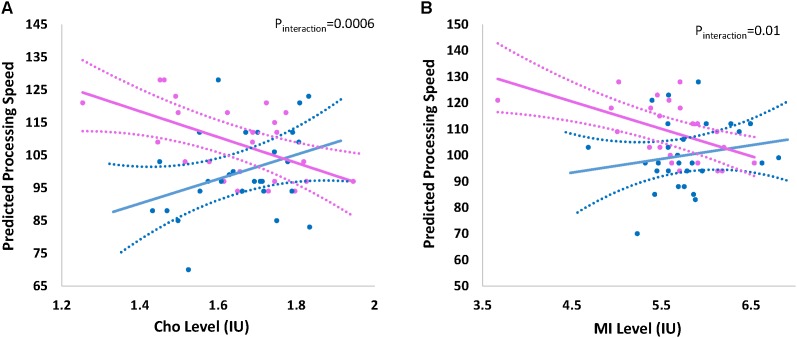
Effect of (A) choline and (B) myo-inositol on processing speed by sex. Graph represents the effect of (A) choline (Cho) and (B) myo-inositol (mI) on the predicted processing speed of participants by child’s sex Sex-stratified regression models are adjusted for age at visit/testing. Blue and pink indicates the effect for males and females, respectively. Dashed lines represent 95% confidence intervals. Actual individual level data are overlaid for males (blue circles) and females (pink circles). Interaction p-value represents the p-value for the formal two-way interaction between metabolite level and child’s sex in the linear regression model.